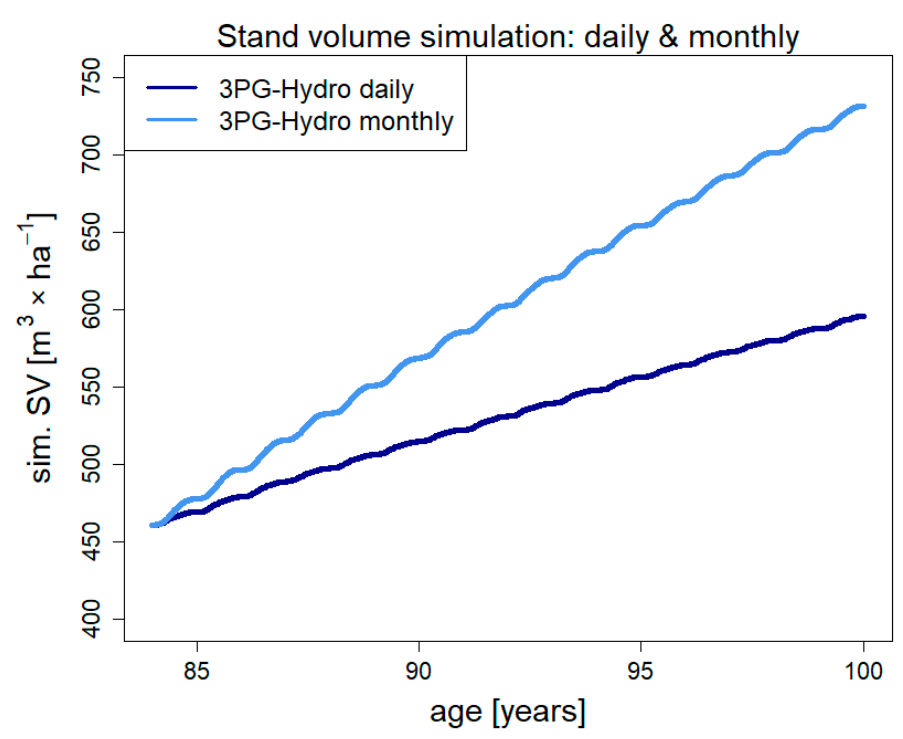
Figure 5. Differences in simulated stand volume (SV) growth at Heidelberg over the period of 14 years using a modified precipitation data